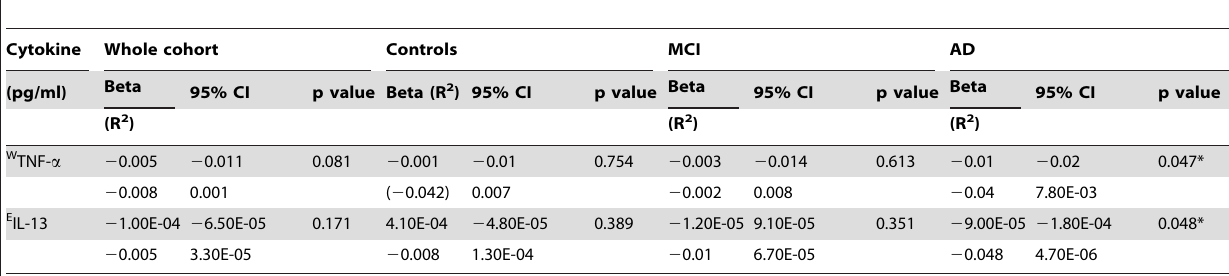
Table 4. Summary statistics for the multiple linear regression model assessing the relationship between inflammatory proteins and brain MRI measures (whole brain volume and left entorhinal cortex).